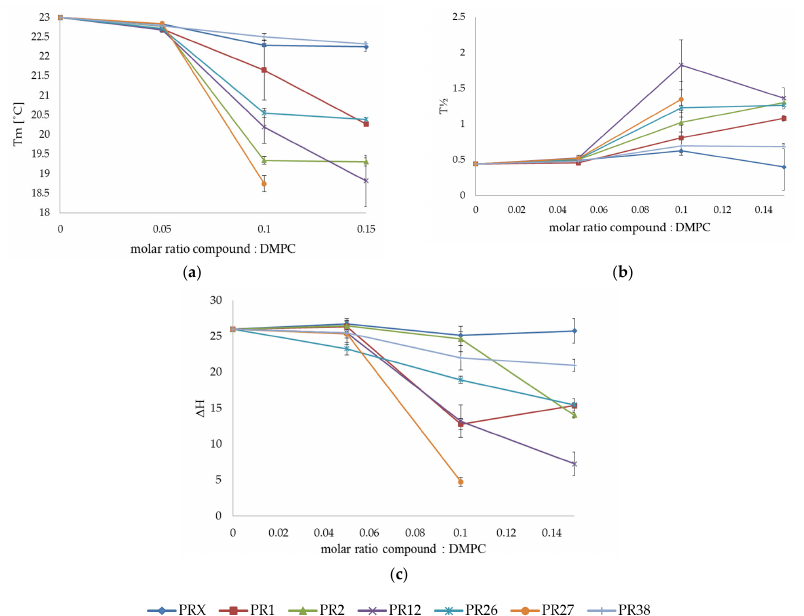
Figure 4. Influence of studied compounds on the parameters of DMPC main phase transition: tem ‐ perature ( a ), half ‐ width of the peak ( b ) and enthalpy of phase transition ( c ); mean ± SD, n = 8. 3.1.3. Comparison of the Results Obtained in DSC Studies for DPPC and DMPC All oxicam derivatives studied perturbed the DPPC and DMPC multi ‐ bilayer struc ‐ ture. The effect was more pronounced for DMPC model membranes than for DPPC ones (see Figure 5). It might be explained by the fact that DMPC as a phospholipid with shorter acyl chains than DPPC is characterized by weaker interactions between hydrocarbon chains and more loosely ‐ packed structures, which could provoke easier oxicam derivative incorporation into bilayers formed from DMPC. The extent of changes induced by oxicam derivatives in parameters characterizing lipid phase transition was greater for DMPC phosphatidylcholine possessing shorter acyl chains than for DPPC with longer chains. In both lipids, the transition enthalpy was de ‐ creased by PR1, PR12 and PR27 more effectively than by PR2, PR26, PR38 and piroxicam,